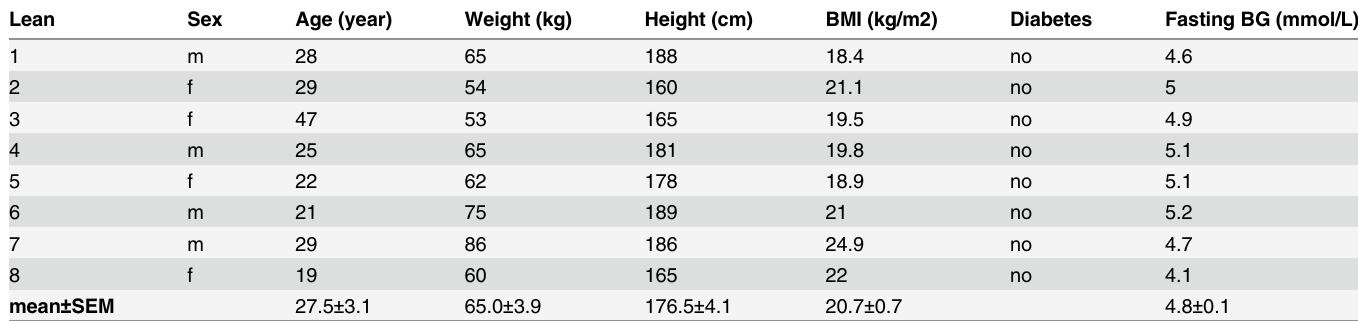
Table 1. Clinical characteristics and biochemical observations for lean volunteers. Lean